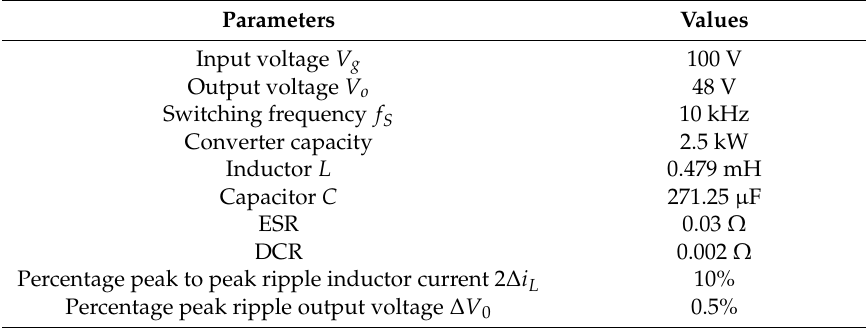
Table 1. Buck converter parameters and values.